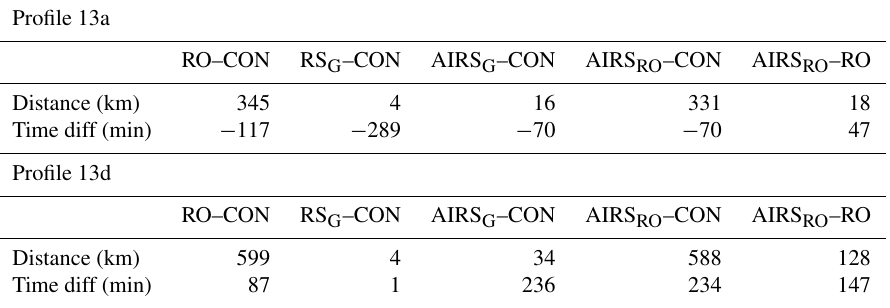
Figure 4. Two snapshots of the troposphere for (top) 19 February 2014 around 18:00UT and (bottom) 20 February 2014 around 00:00UT. Left panels: profiles for CONTRAST, RO, ERA, GFS, RS, and AIRS for the 2 days. Right panels: ERA RH (%, color shading) at 500hPa, ozone values (white contours: values ≥ 50ppbv are solid, otherwise dashed), and winds (black arrows). The white X marks the location of Guam. The locations of CONTRAST, RO, RS, and AIRS profiles are marked. Additional squares indicate other RO measurements. The squares marking the locations of the RO and CONTRAST locations are colored according to the RH of each profile at the 500hPa level (matching the color bar). Table 1. Distances and time differences between different the collocated profiles of rf13a and rf13d at the lowest point for each profile. Note that both the aircraft and RS profile will move away from Guam with higher altitudes and that RO profiles are also not completely vertical, especially in the lower and